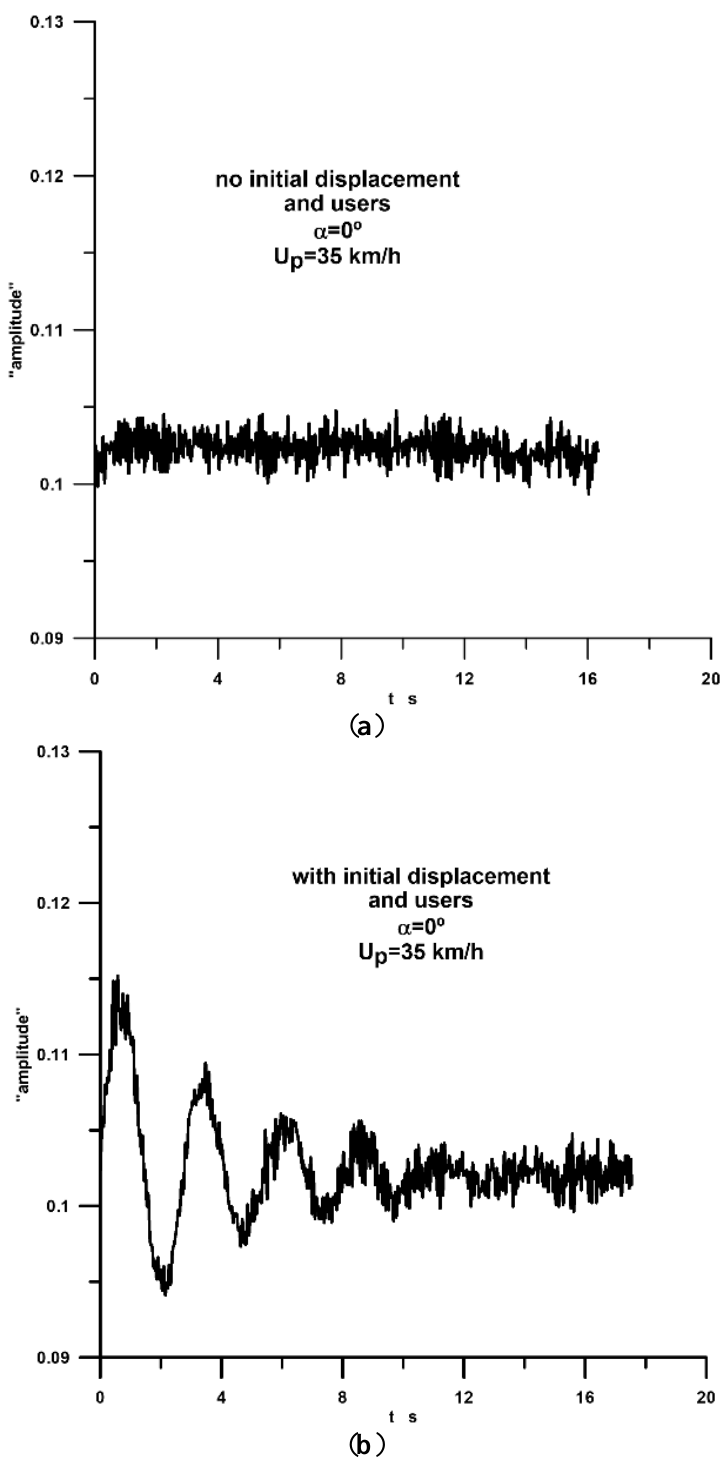
Figure 15. Deck torsional movement without and with previous swing displacement with users ( a , b ). The damping coefficient evolution, as a function of both wind velocity and the angle of attack, is shown in Figure 16a, its values being always positive with the initial displacement, drag playing a role in this